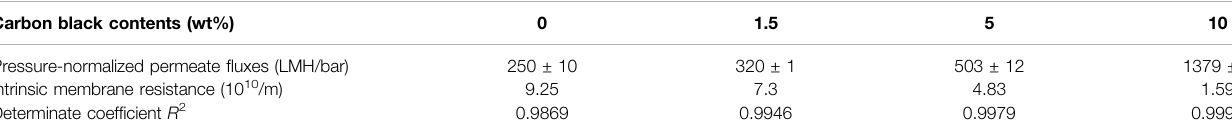
TABLE 1 | The effect of carbon black content on the property of REM samples. Carbon black contents